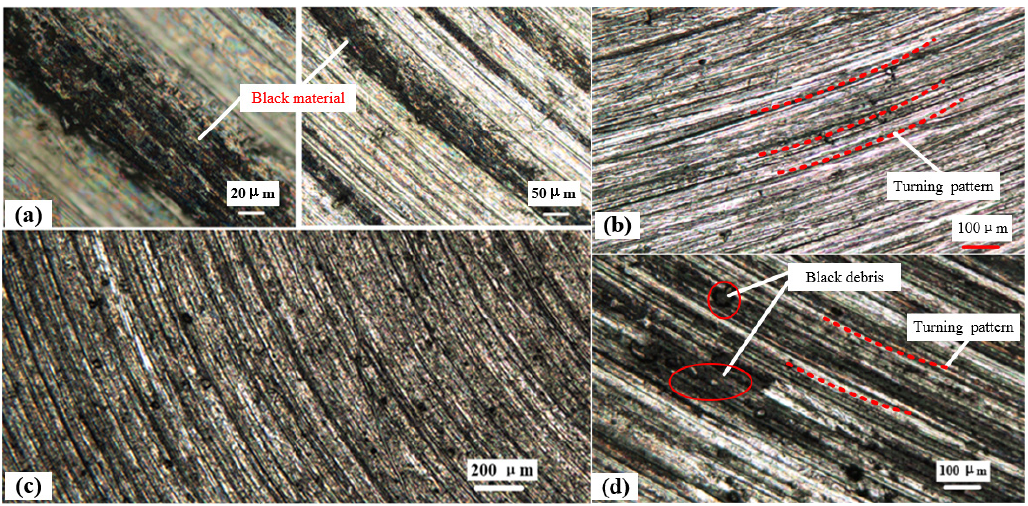
Figure 5. The surface morphology of 316L after friction with lubrication pressure of 4 MPa: ( a ) the morphology of the 316L sample after friction; ( b ) the original morphology of the 316L sample; ( c , d ) the morphology of the 316L sample in different magnification after friction.